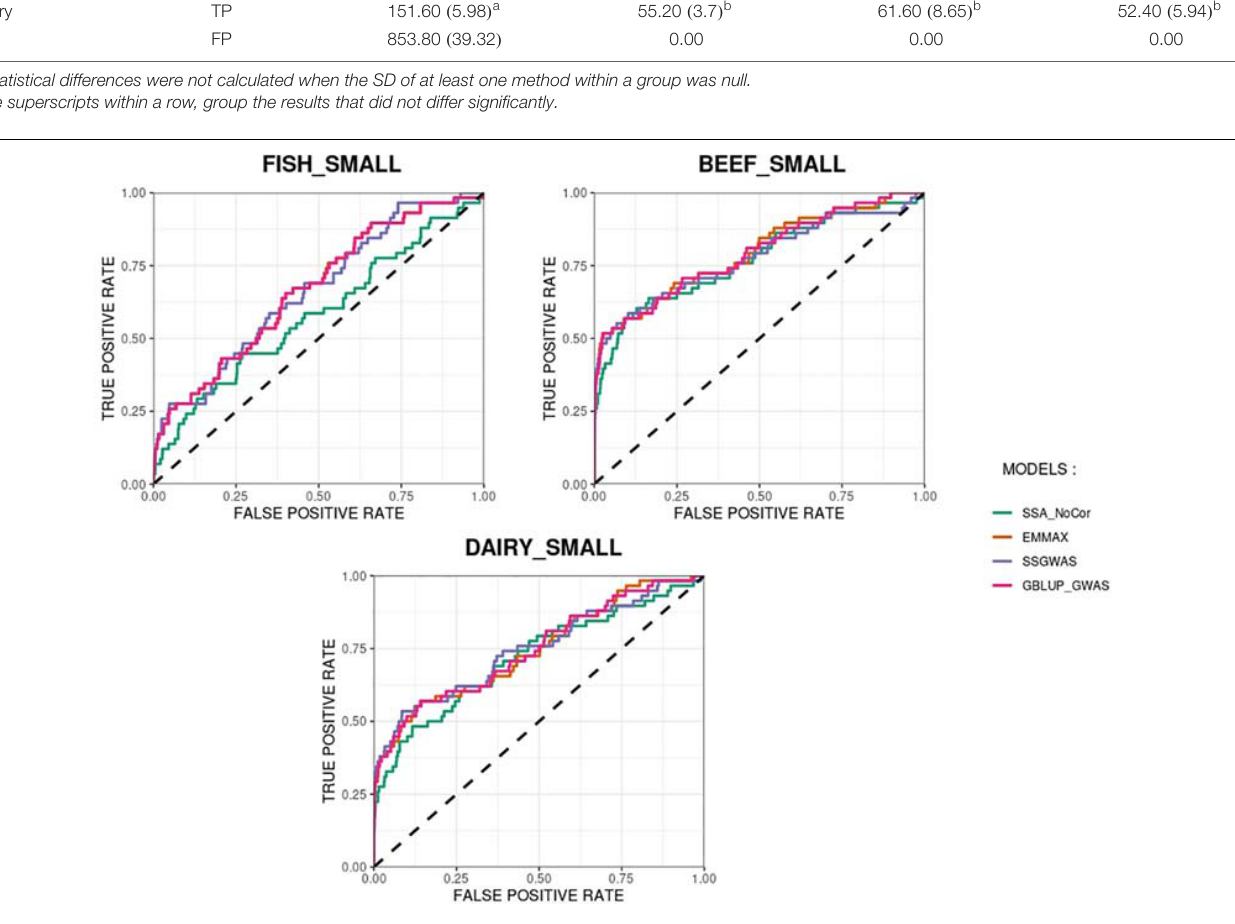
improved in the large populations, but SSA-NoCor still had poorer performance compared to other methods. The fact